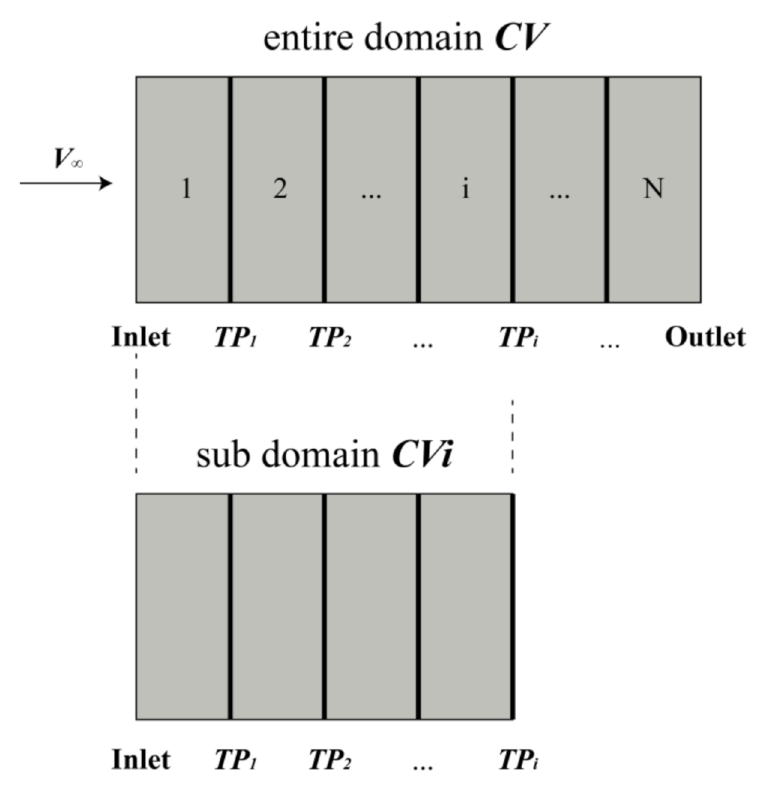
Figure 3. Control volume definition and domain division